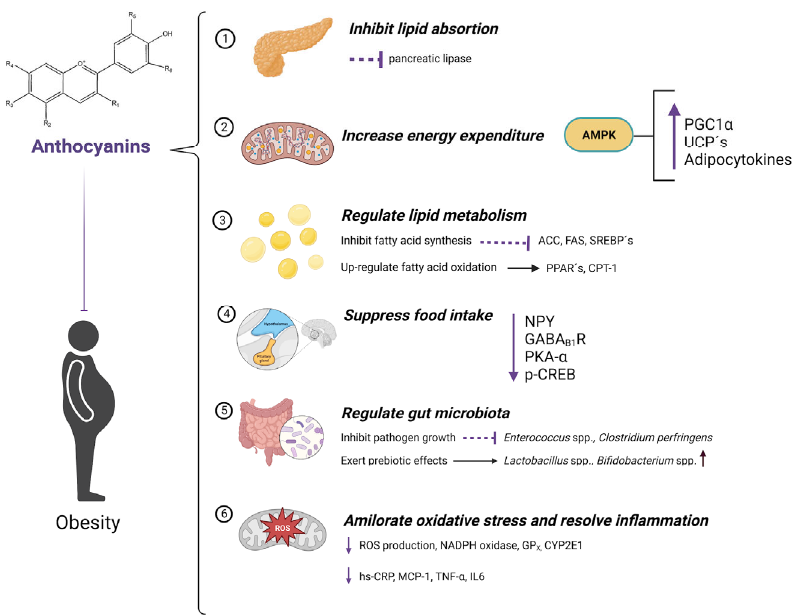
Figure 4. Molecular mechanisms of anti ‐ obesity effects of anthocyanins. (1) Various anthocyanins are strong pancreatic lipase inhibitors; (2) These pigments can up ‐ regulate AMPK expression which increases the expression of PGC1 α and UCP’s, and the excretion of adipocytokines; (3) Anthocyanins inhibit fatty acid synthesis by down ‐ regulating the expression of ACC, FAS, and SREBP’s and by up ‐ regulation of fatty acid oxidation by increasing the expression of PPAR´s and CPT ‐ 1; (4) Pigments, such as anthocyanins, suppress food intake by reducing the expression of NPY, GABAB1R, PKA ‐α , and p ‐ CREB; (5) Anthocyanins can inhibit growth of Enterococcus spp. and Clostridium perfringens, pathogens, and exert prebiotic effects enhancing the growth of beneficial strains, such as Lactobacillus spp. and/or Bifidobacterium spp.; (6) These pigments can ameliorate oxidative stress by reducing ROS production, inhibit expression of NADPH oxidase and GPx, as